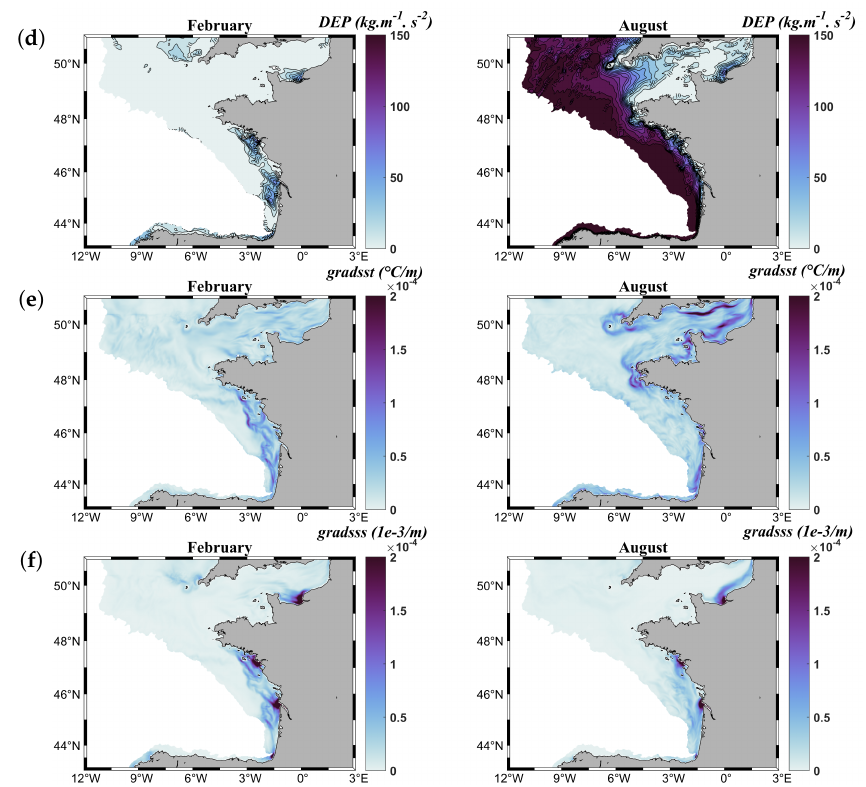
Figure 2. Illustration of monthly hydrological Essential Ocean Variables (EOVs) in February ( left ) and August ( right ): ( a ) Sea surface temperature (SST), ( b ) sea surface salinity (SSS), ( c ) mixed layer depth (MLD), ( d ) deficit of potential energy (DPE), ( e ) SST gradients (GRADSST) and ( f ) SSS gradients